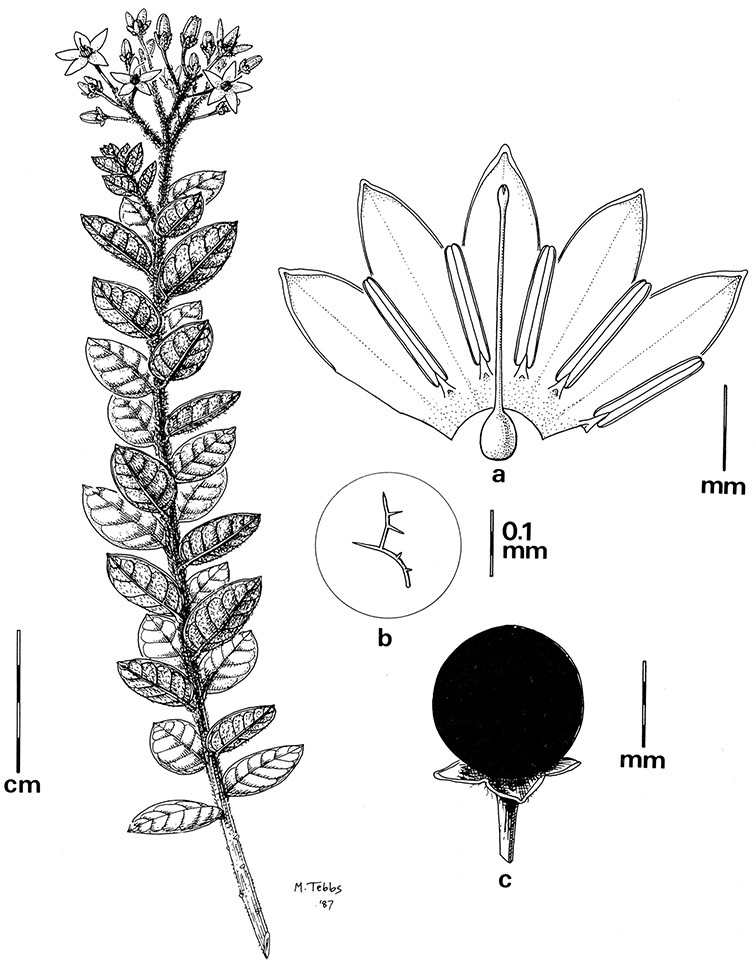
Solanum leiophyllum Benth. (A–C drawn from Hartweg 812). Reproduced from Knapp (1989) with permission of the Natural History Museum Botany Library.